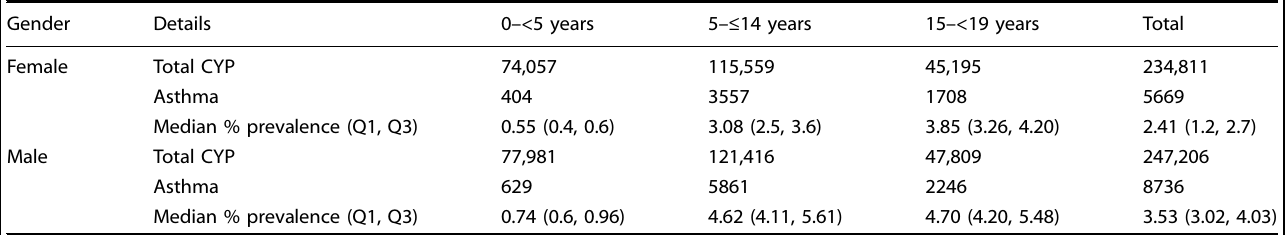
Table 1. Numbers of children and young people (CYP) diagnosed a with asthma in 350 general practices in North West London in the 12 months from April 2018.